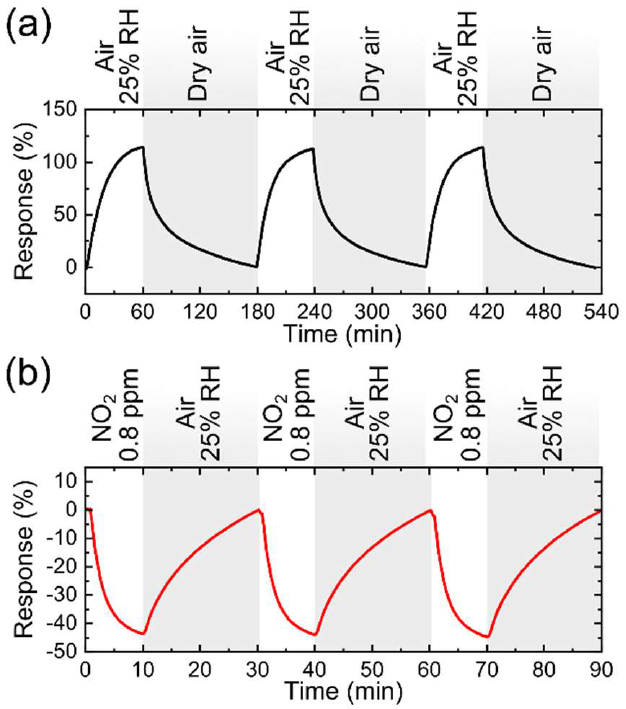
Figure 7. Real time response of the paper-based sensor tested at 23 °C ( a ) with intervals of dry air (0% RH) and 25% RH ( b ) for 0.8 ppm of NO 2 in an environment with RH 25% at 23 °C.